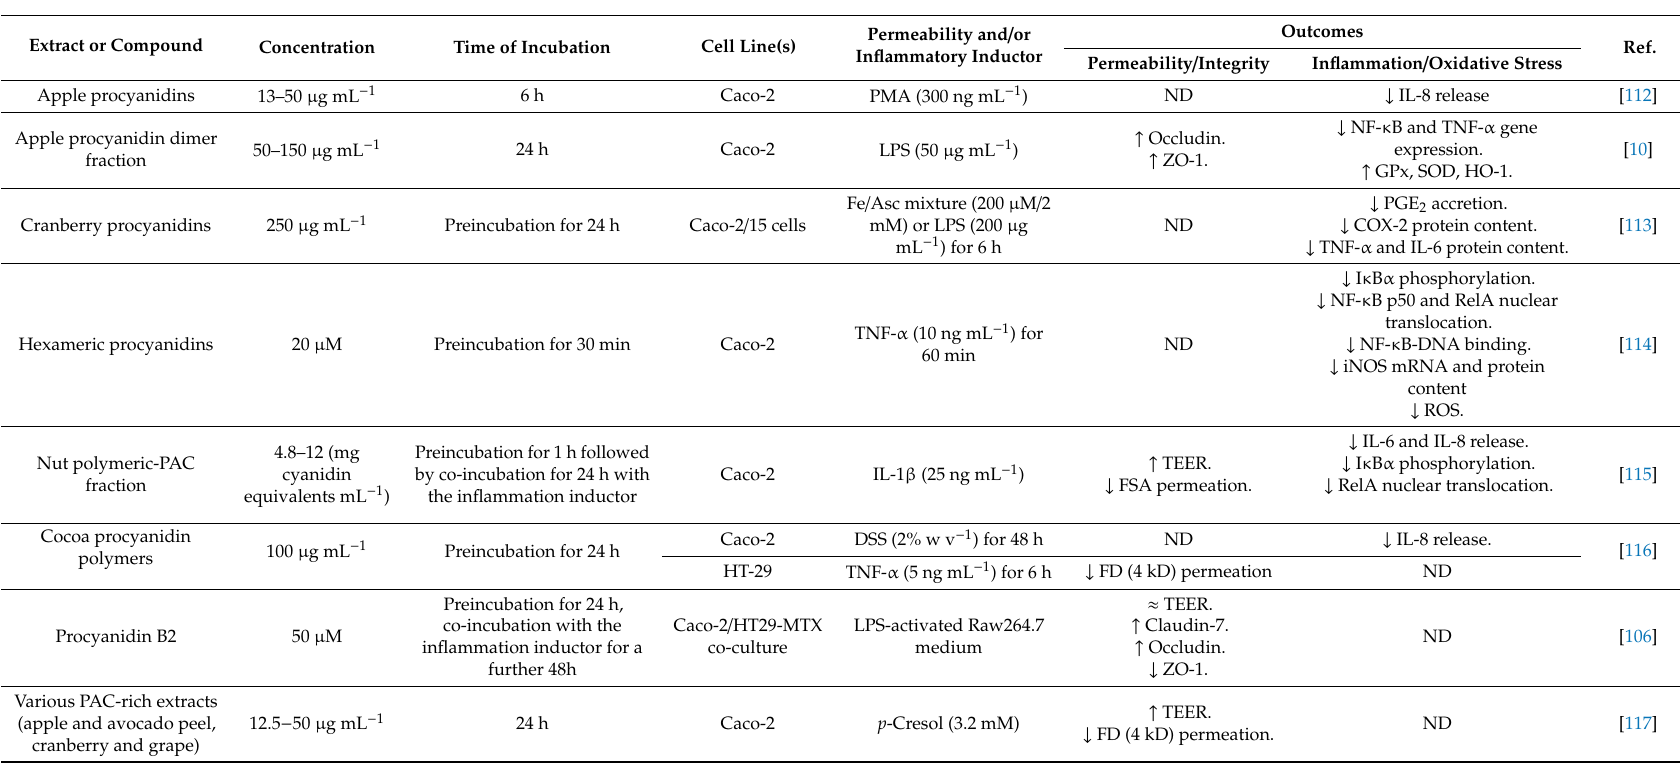
Table 1. Interaction of PACs with permeability and inflammatory markers in cell culture models of intestinal